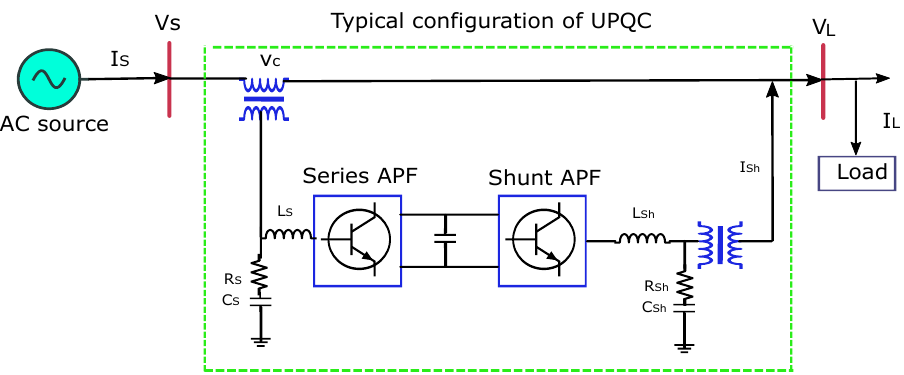
Figure 3. General configuration of UPQC for voltage sag mitigation in AC grid